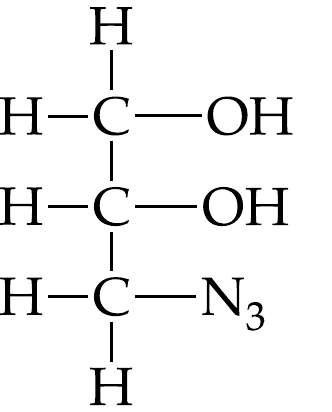
Figure 1. Chemical structure of azidated glycerol (AG).